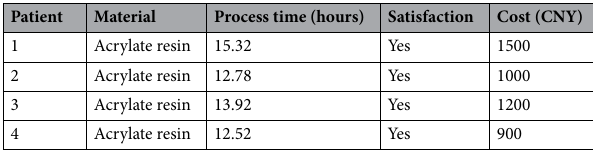
Table 1. The datas of 3D printing processing. CNY Chinese